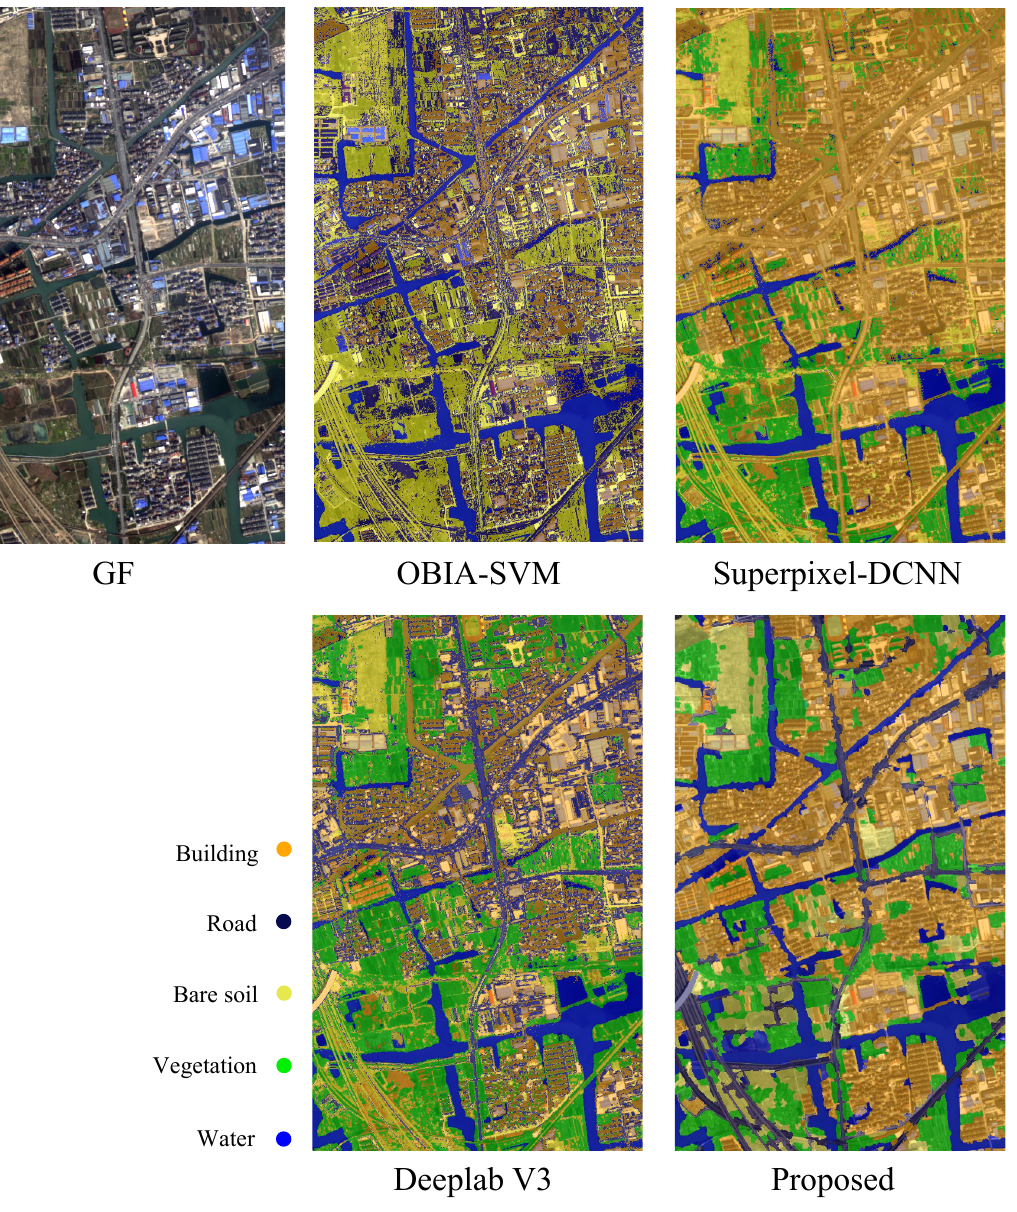
Figure 8. Qualitative classification of the competitive and proposed methods on